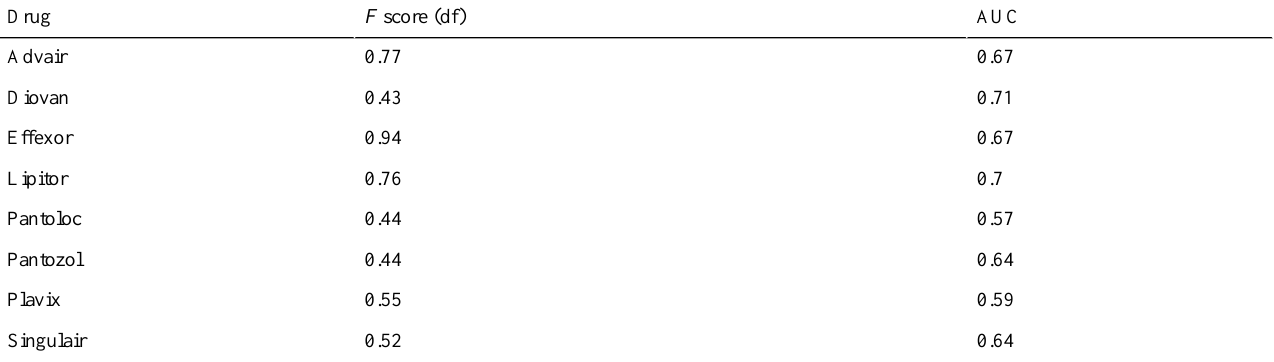
Table 3. Accuracy of adverse drug reaction (ADR) identification by using QLRS, tested against the SIDER dataset with most discordant ADRs (MDADRs)